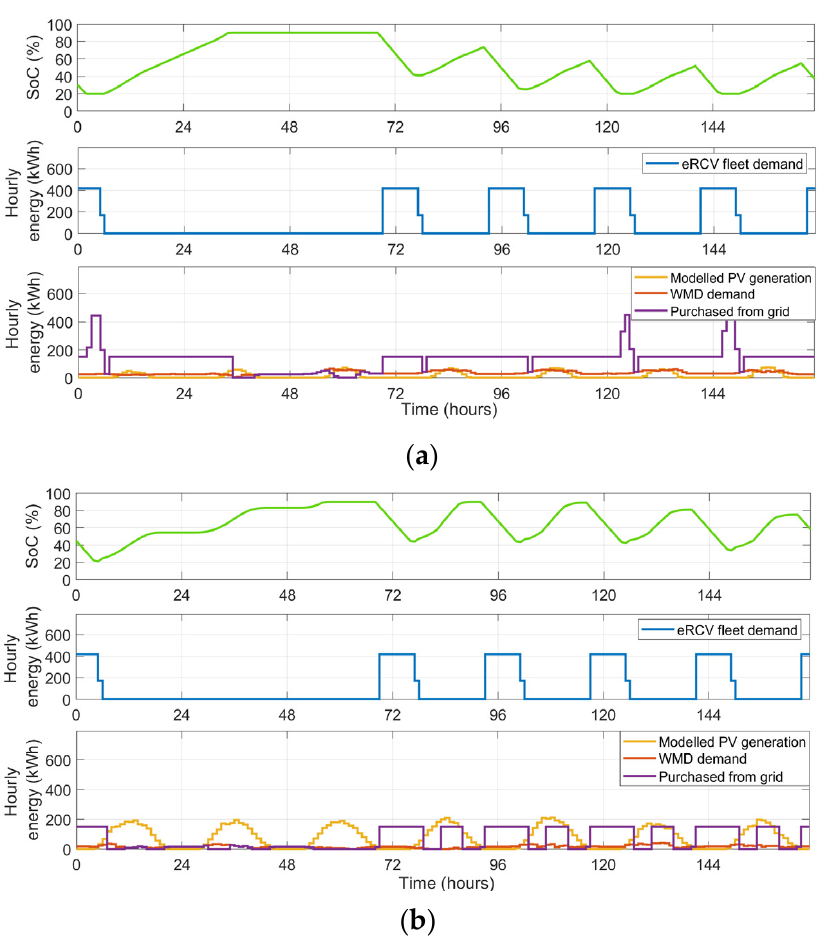
Figure 14. Hourly energy distribution for scenario 3 with a BESS capacity of 5 MWh in a week in ( a ) February and ( b ) July.